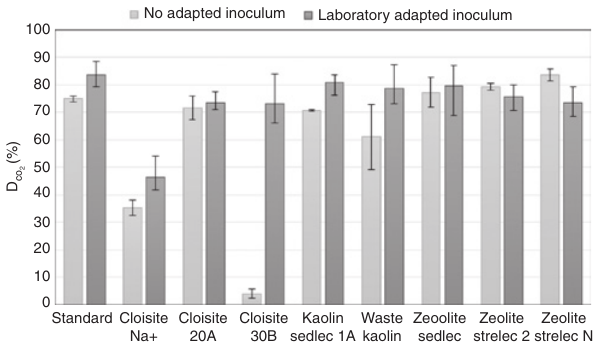
Figure 2: The level of PVA 88-8 biodegradation with no adapted inoculum and laboratory-adapted inoculum in the presence of a selected group of clay minerals ( ± standard deviation).